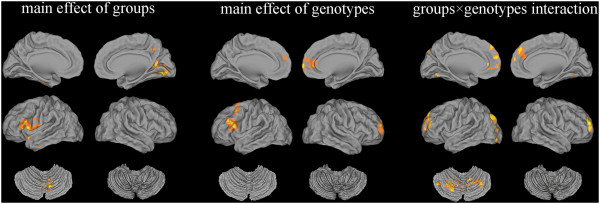
Groups × genotypes ANOVA of ALFF. Thresholds were set at a correctedP<0.05, determined by Monte Carlo stimulation.